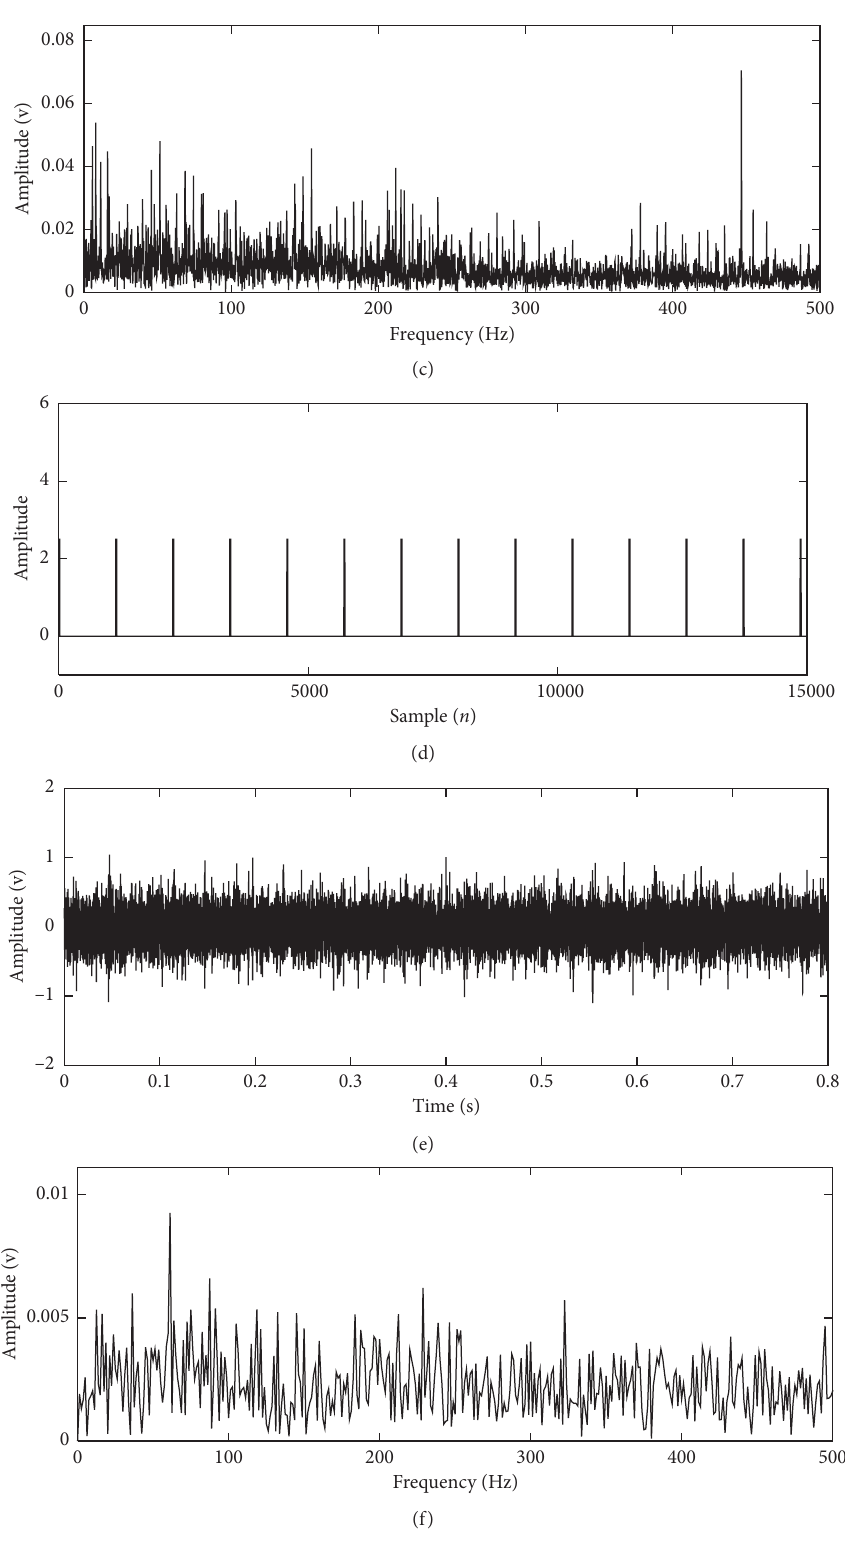
Figure 22: The blind source extraction results using the cICA method. (a) The constructed inner race fault reference signal. (b) The extracted signal by using the signal shown in Figure 22(a) as reference. (c) The envelope demodulation spectral analysis of the signal shown in Figure 22(b). (d) The constructed outer race fault reference signal. (e) The extracted signal by using the signal shown in Figure 22(d) as reference. (f) The envelope demodulation spectral analysis of the signal shown in Figure